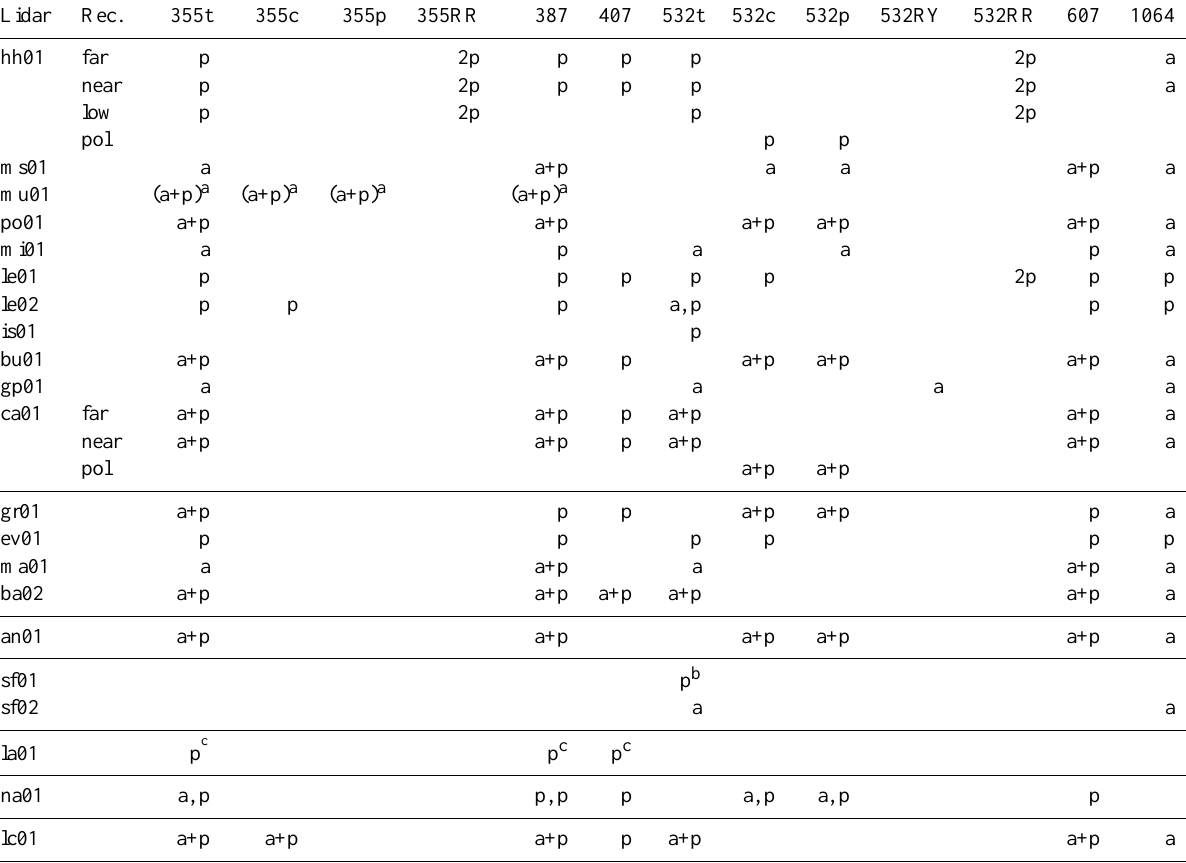
a alternative configurations; see text for details b CuBr laser, emission wavelength at